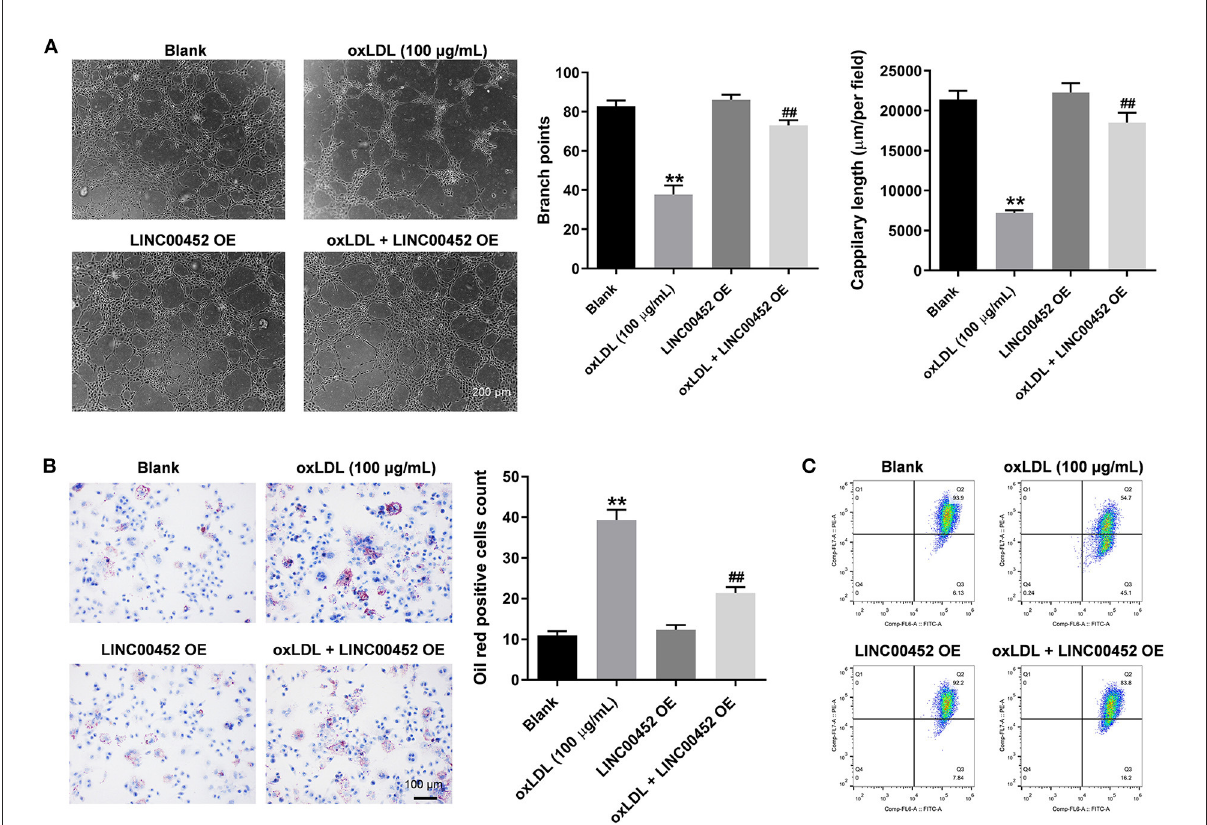
FIGURE3 LINC00452 overexpression reverses oxLDL-induced inhibition of HUVECs angiogenesis. HUVECs were treated with oxLDL (100 µ g/mL) for 24h. Next, HUVECs were transfected with pcDNA3.1-LINC00452 using Lipofectamine 2000 for 24h. (A) Tube formation assay was performed to measure the branch points and capillary length of HUVECs. (B) Oil-red O staining was used to detect the lipid accumulation in HUVECs. (C) Flow cytometry assay was performed to detect the level of MMP. ** P < 0.01 compared to control group. ## P < 0.01 compared to the oxLDL (100 µ g/mL) group, n =